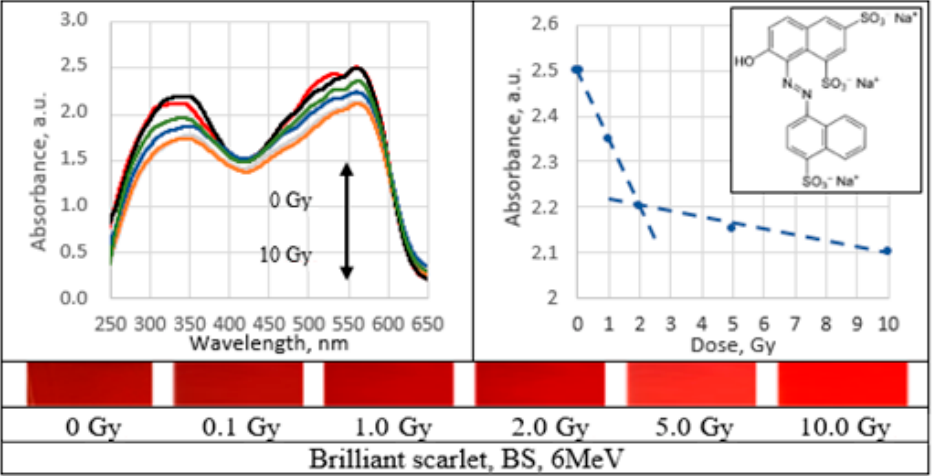
Figure 3. Absorbance spectra and sensitivity of the irradiated brilliant scarlet films.